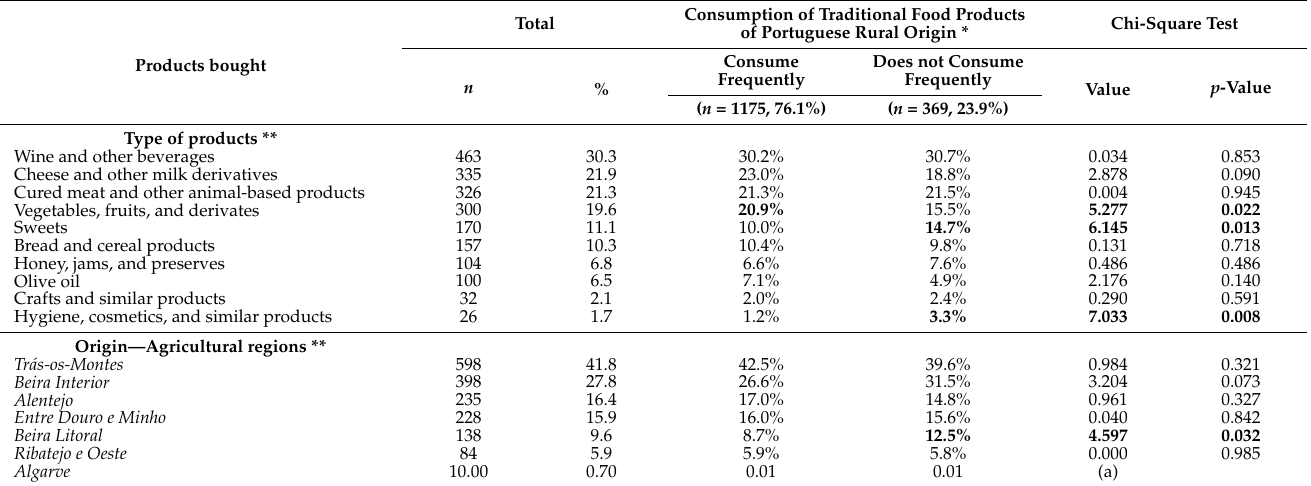
Table 2. Type of products acquired and regions of